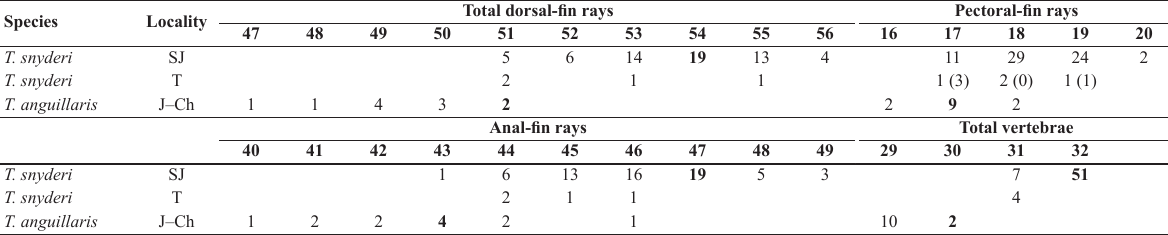
Table 2. Comparison of Taenioides snyderi from Japan and Taiwan, and T. anguillaris . Species